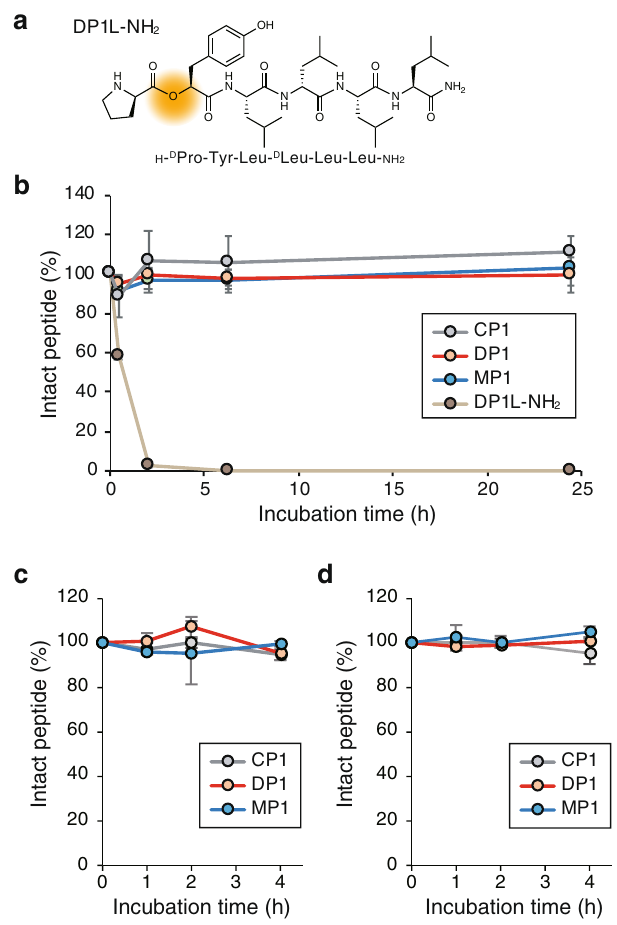
Fig. 6 | Stabilities of cyclic hexapeptides in serum and simulated gastric/ intestinal fl uids.a Chemicalstructureof DP1L-NH 2 . b Mouseserumstabilityof CP1 (gray), DP1 (orange), MP1 (blue), and DP1L-NH 2 (brown). c Stability in a simulated gut fl uid. 98% of a control peptide (somatostatin) was degraded at 4h under the same conditions. d Stabilityin asimulated intestinal fl uid.94%ofacontrolpeptide (oxytocin) was degraded at 4h under the same conditions. The degradation pro- fi les of the control peptides are shown in Supplementary Fig. 50. In ( b ) – ( d ), each point represents the mean value, and the error bars the standard deviation from experiments carried out in